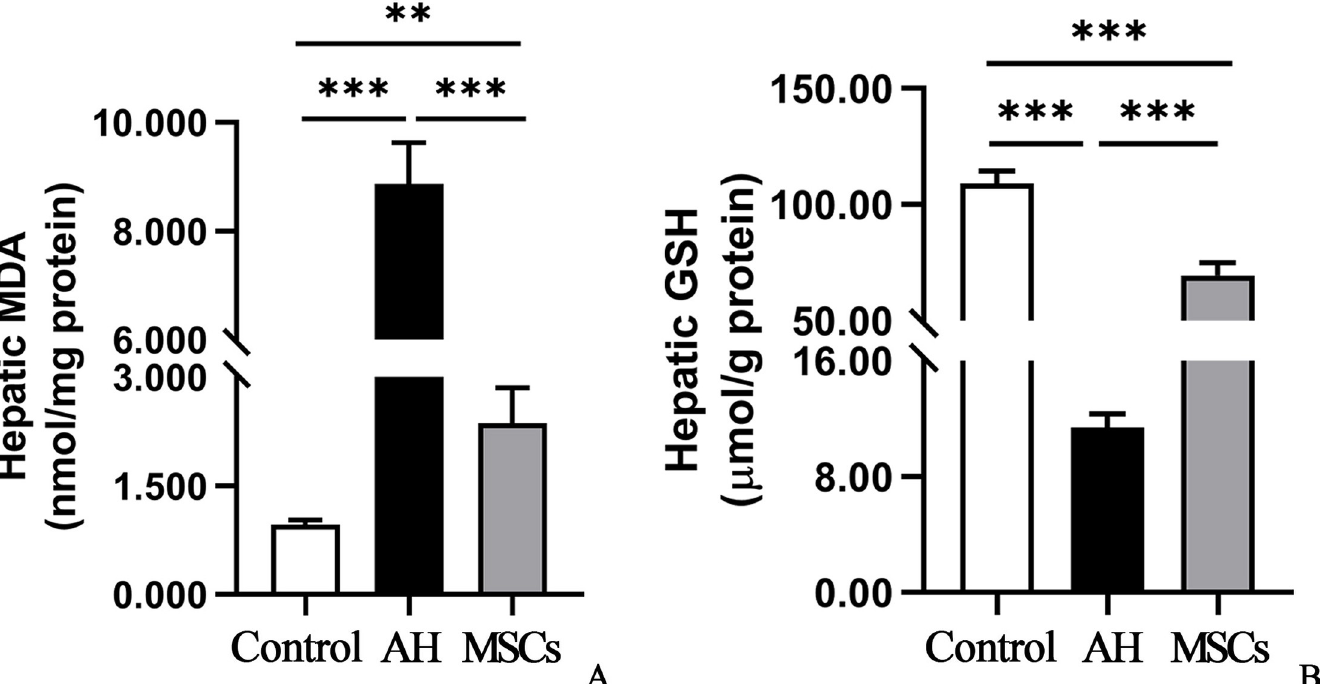
Fig 5. A,B MSCs alleviated hepatic oxidative stress: hepatic MDA (A) and GSH (B) contents. Five mice per group were used. � P < 0.05, �� P < 0.01, ��� P < 0.001. GSH, glutathione; MDA, malondialdehyde; MSCs, mesenchymal stem cells.